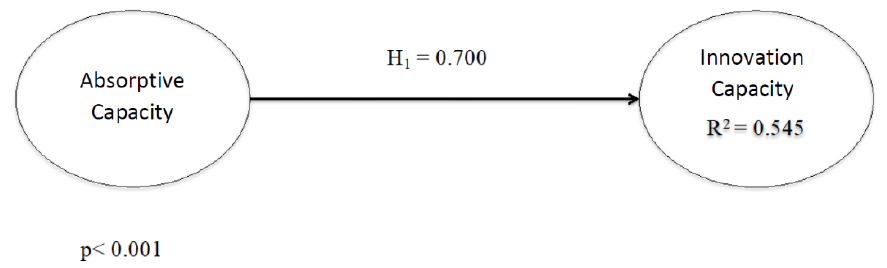
Figure 2. Direct model. Table 5. Causal relationships: total, direct, and indirect